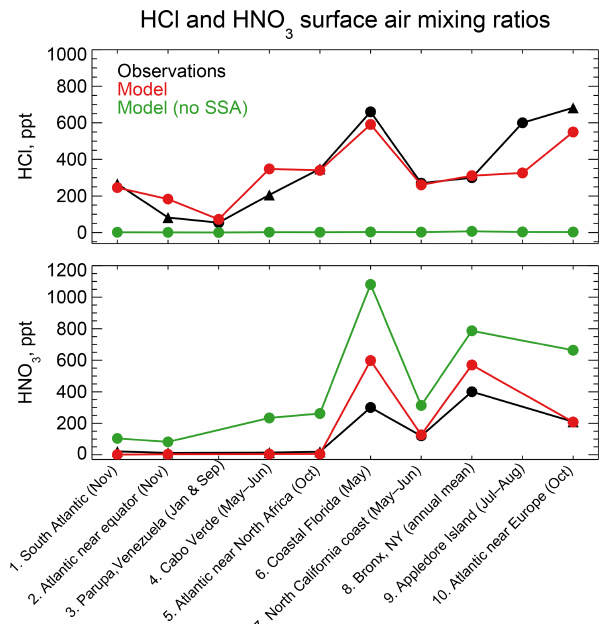
Figure 4. HCl and HNO 3 surface air mixing ratios at coastal and island sites and from ocean cruises, arranged from left to right in or- der of increasing latitude. Observations are means (black circles) or medians (black triangles) depending on availability from the pub- lications. Model values are monthly means for the sampling loca- tions. Also shown are results from a sensitivity simulation with no mobilization of Cl − from sea salt aerosol (SSA). References: (1, 2, 5, 10) Keene et al. (2009); (3) Sanhueza and Garaboto